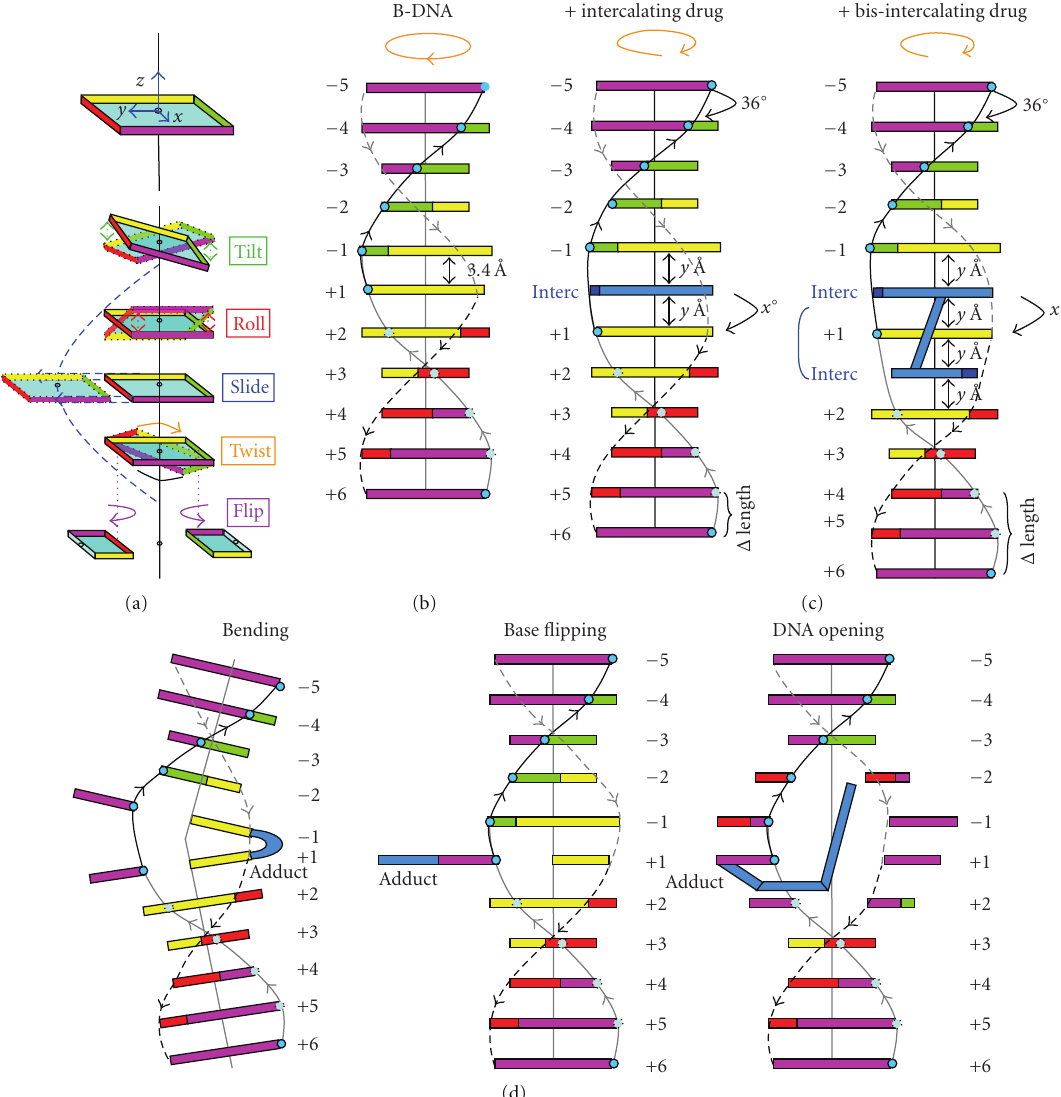
Figure 1: Schematic representation of DNA structure. (a) Base pair orientation with x , y, and z axes result in di ff erent kind of rotation (tilt, roll, twist) or slipping of the bases (slide, flip) regarding to the helix central axis. (b) Native B-DNA with nearly 11 base pairs within one helix turn. (c) Mono- or bis-intercalation between adjacent base pairs result in an unwinding of the DNA helix (orange arrow on the top) and a lengthening of the DNA helix ( Δ Length) depending on the x ◦ and y ˚A values that are specific for a defined DNA intercalating compound. (d) Representation of the DNA bending, base flipping, or double strand opening induced by some DNA destabilizing alkylating agents (adduct). Adapted from Calladine and Drew’s schematic boxes representation